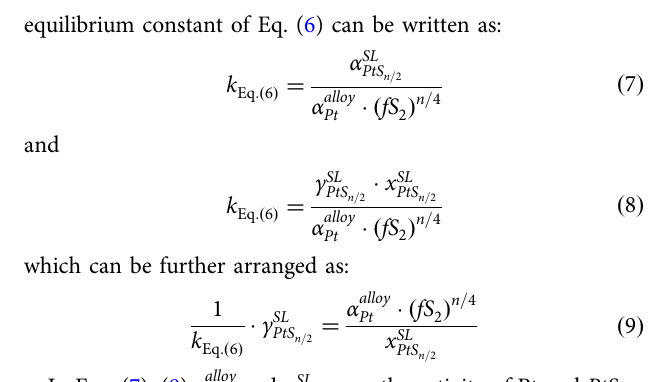
Fig. 2 Dependence of the Pt and Pd concentration in the silicate melt and D SL = SM Pt ; Pd on the Pt and Pd concentration in the sul fi de liquid. a , b The Pt and Pd concentration in the silicate melt increases exponentially with increasing the Pt and Pd concentration in the sul fi de liquid. The dashed gray lines show the co-variation of the Pt and Pd concentration in the silicate melt and sul fi de liquid if the partitioning of Pt and Pd between sul fi de liquid and silicate melt obeys Henry ’ s law. c , d D SL = SM Pt ; Pd increase linearly with increasing the Pt and Pd concentration in the sul fi de liquid. The literature data are taken from M&B 2014 (ref. 4 ), Fleet 1996 (ref. 10 ), Fleet 1999 (ref. 12 ), Stone 1990 (ref. 9 ), Bezmen 1994 (ref. 13 ), and Crocket 1997 (ref. 11 ). Note that the literature data of M&B 2014, obtained using in-situ micro-analytical technique of LA – ICP – MS, are systematically consistent with the present results. The other literature data ( fi lled gray symbols) were obtained by neutron activation analysis of bulk samples, and an effective separation of the silicate and sul fi de phases was questioned 8 . Source data are provided in Supplementary Data